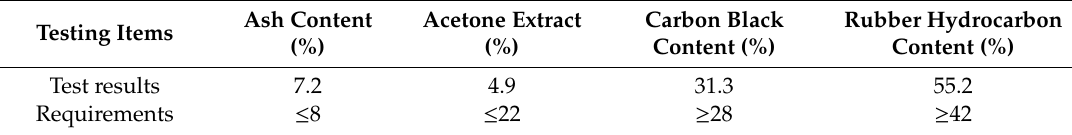
Table 3. Chemical properties of the rubber powder.